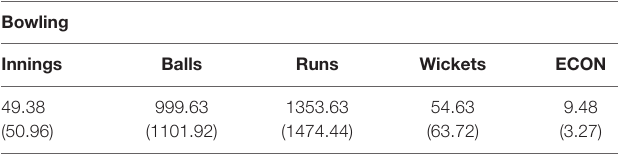
TABLE 1 | Average (SD) bowlers performance statistics.